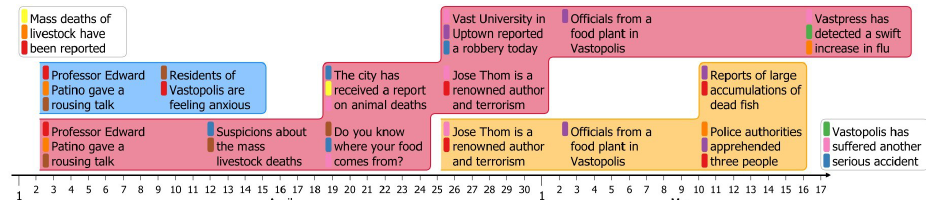
Figure 19. Nguyen et al. present the SchemLine system [39]. Image courtesy of Nguyen et al.